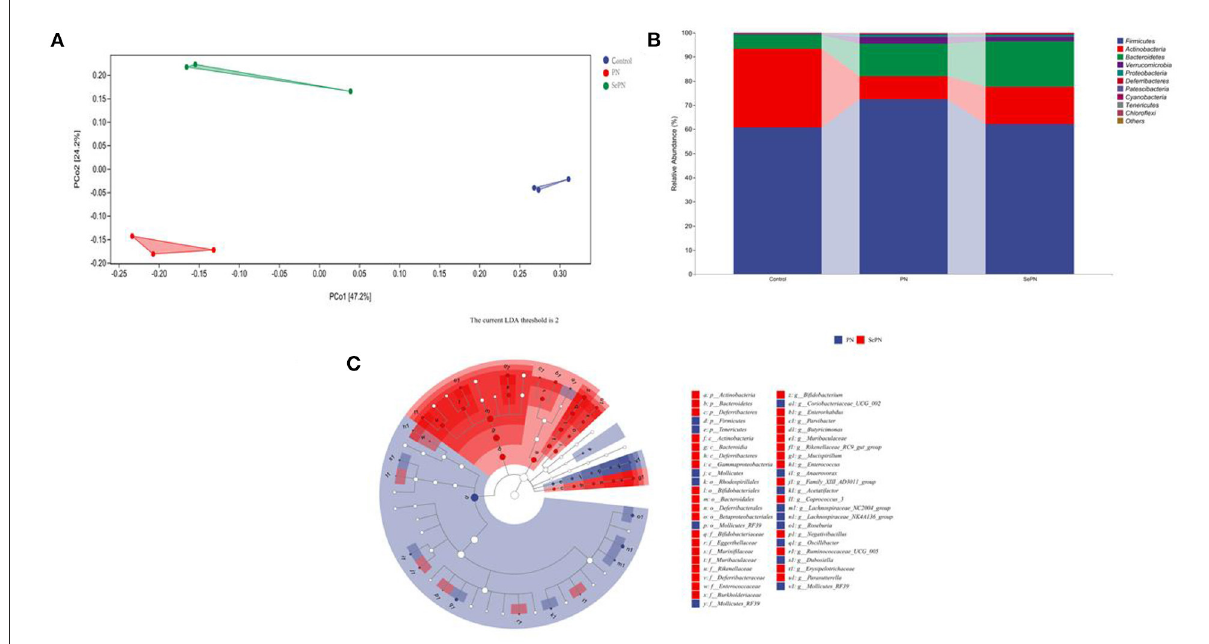
FIGURE6 Changes of gut microbiota abundance in mice. (A) The principle coordinate analysis (PCoA) plot for the samples in the different groups. (B ) The gut microbiota composition at the phylum level. (C) Taxa with significant differences between groups based on linear discriminant analysis (LDA) effect